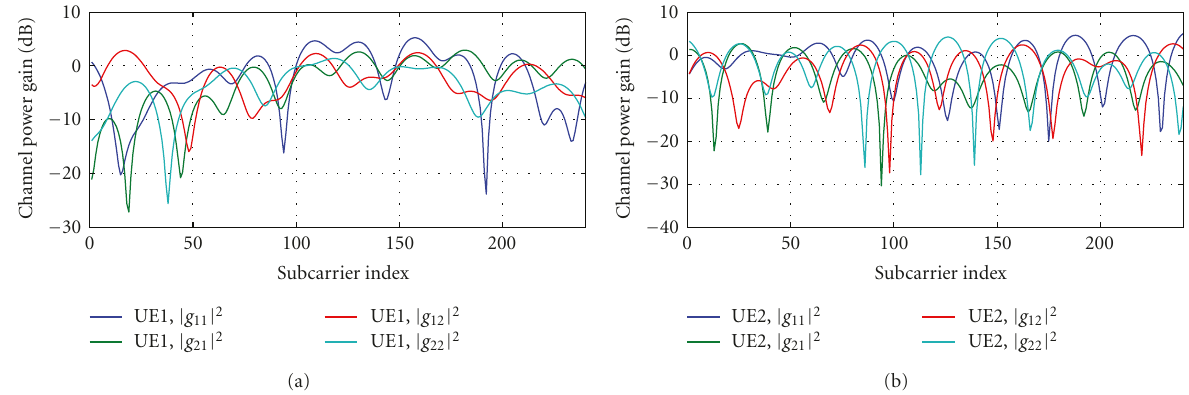
Figure 3: Channel power gain snapshot between the UEs and the BS according to Figure 2; g ij denotes the subcarrier frequency response between the j th transmitter of the UE and the i th receiver at the BS.